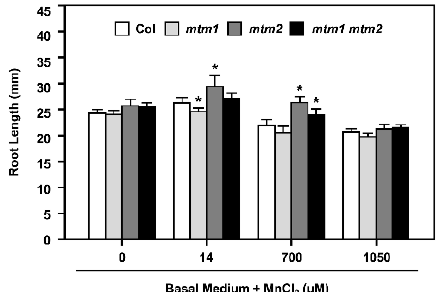
Figure 6. Root lengths of Col, mtm1 , mtm2 , and mtm1 mtm2 -double mutants with Mn deficiency or by extra Mn supply. Seedlings were grown on the basal medium plates without MnCl 2 supply or with extra MnCl 2 of 14 μM (normal Mn), 700 μM (50 - fold increase), or 1050 μM (75 -fold increase) for 6 days, then the root lengths were measured. Data are mean ± SD of three independent repeats. n = 30 seedlings. * Significant at p < 0.05 compared with the Col.